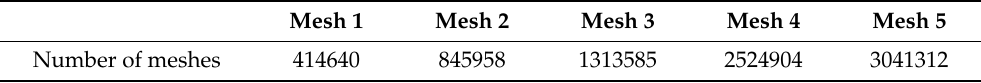
Table 2. Grid independence verification.